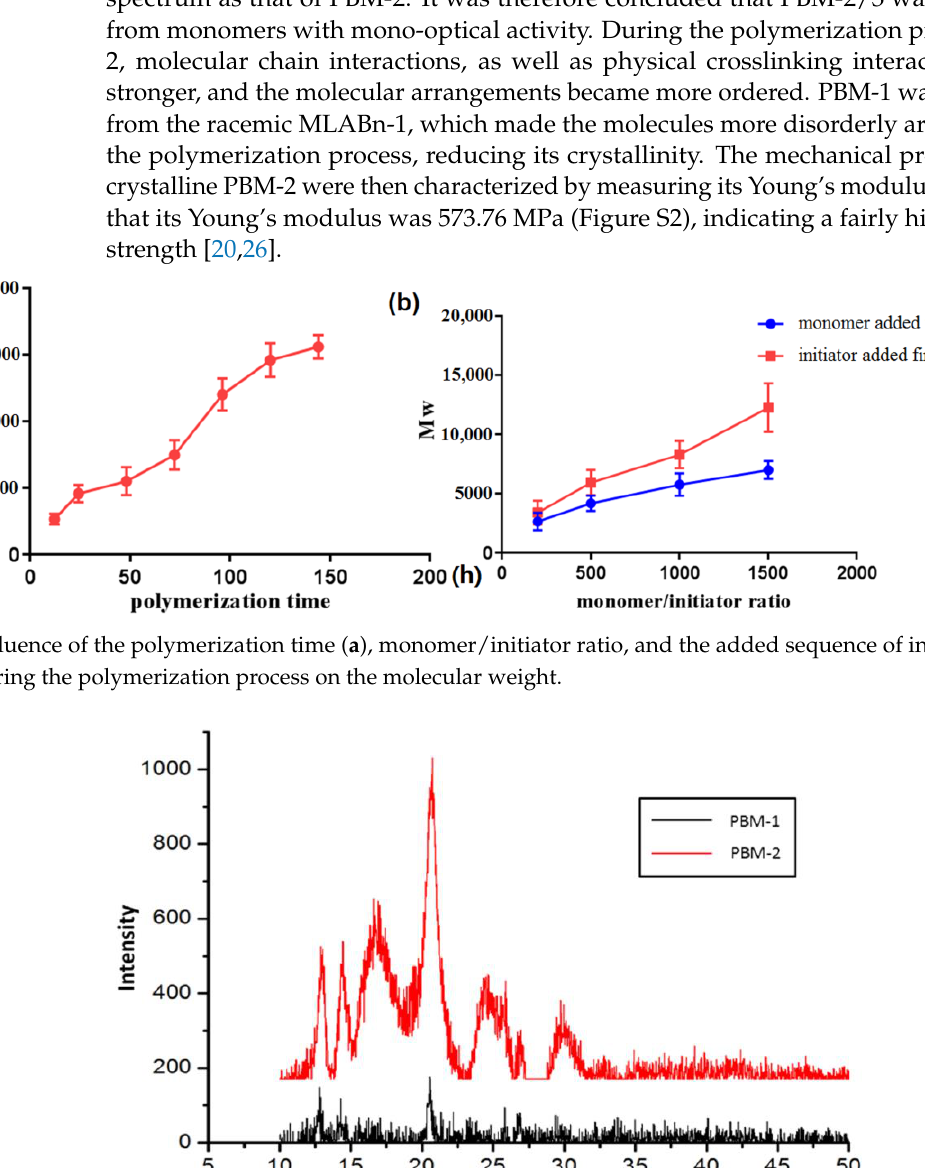
Figure 4. X-ray diffraction spectrum of PBM.